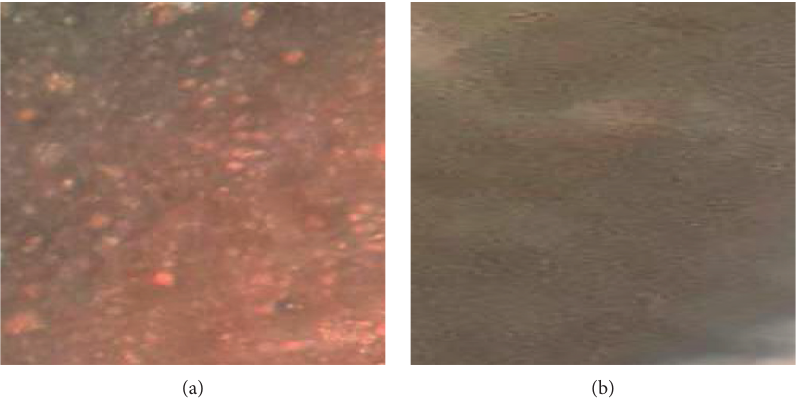
Figure 7: The optical microscope image of nanomaterials. (a) Nano-ZnO particle. (b) Nano-TiO